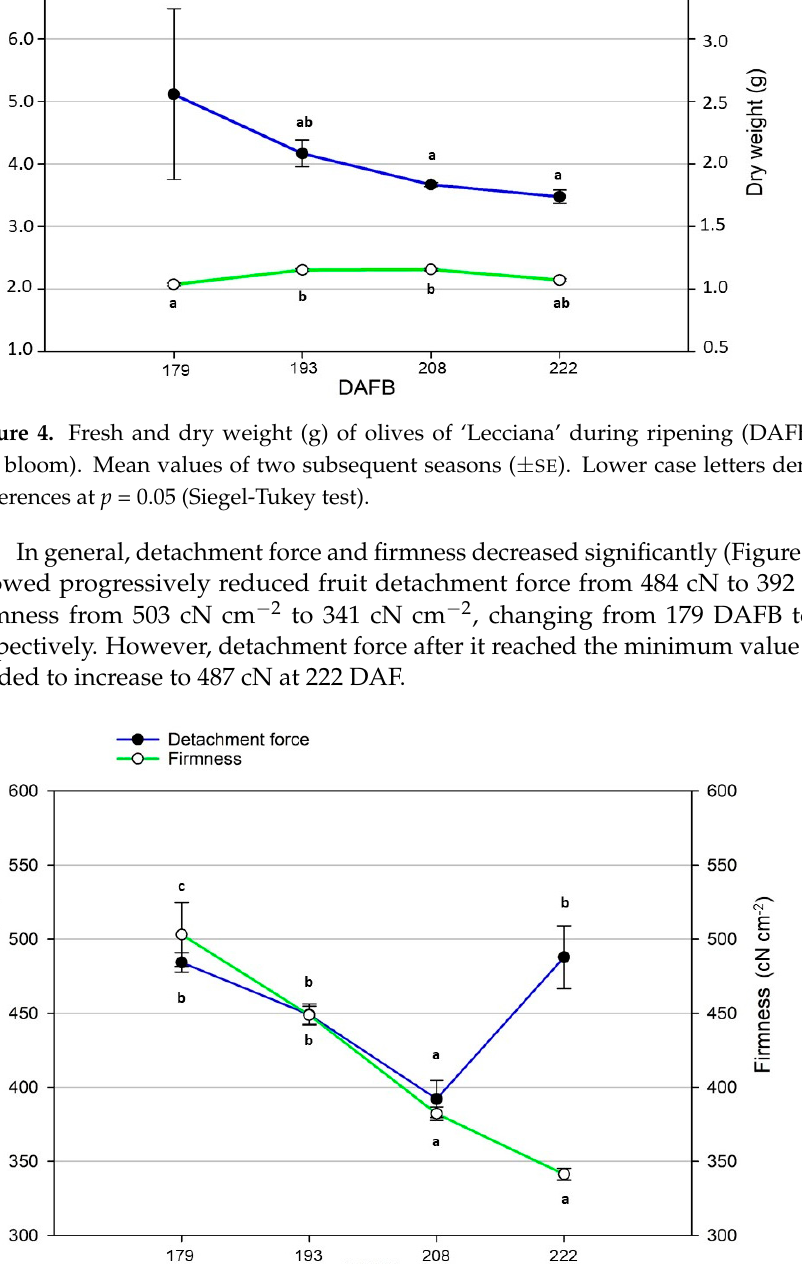
Figure 6. Jaen index ( n ) and detachment index (N g − 1 ) of olives of ‘Lecciana’ during ripening (DAFB = days after full bloom). Mean values of two subsequent seasons (± SE ). Lower case letters denote statistical differences at p = 0.05 (Siegel-Tukey test).